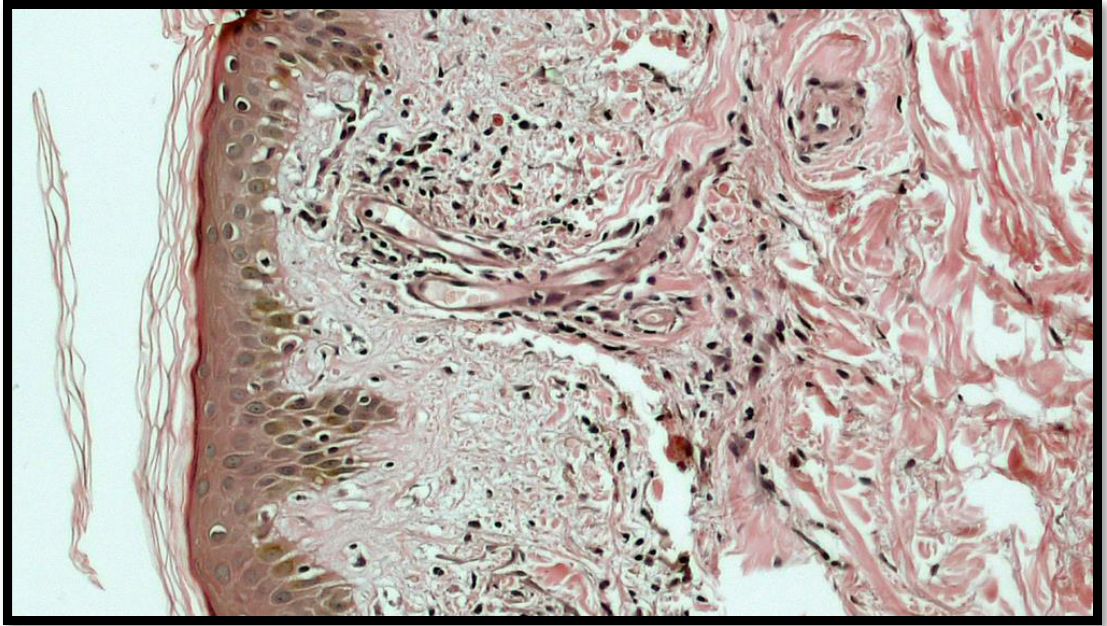
Figure 4. Histological preparation showing a greater magnification of the lymphomonocitary infil- trate, which was mainly distributed around the blood vessels of the superficial dermis with occasional presence of siderophages. (Hematoxylin-Eosin; Original Magnification 10×).